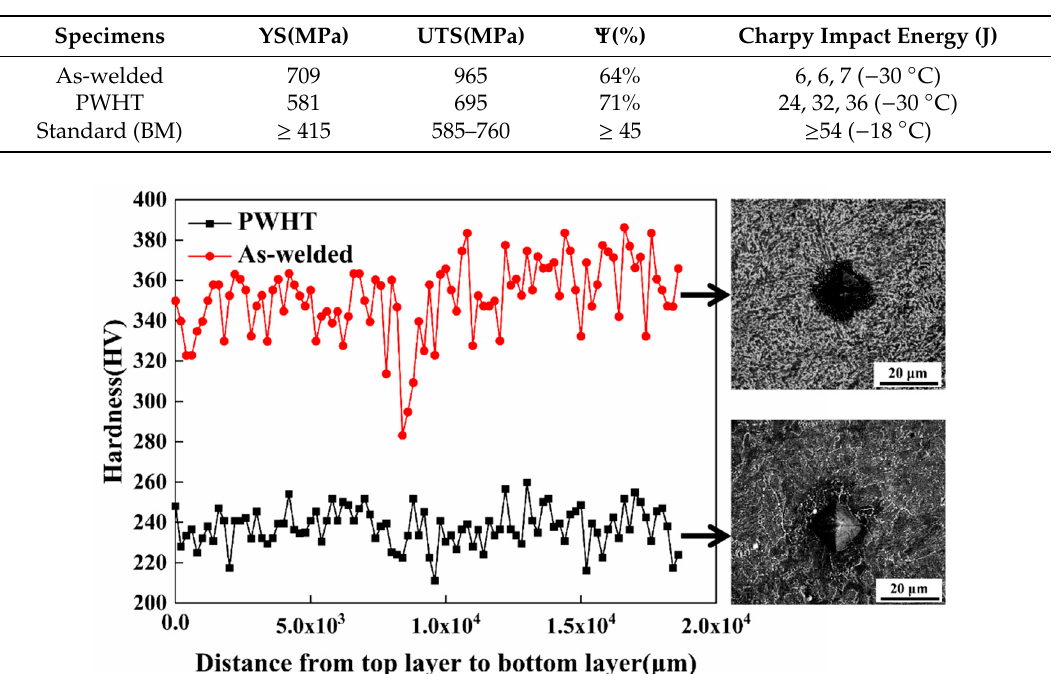
Figure 5. Hardness of the weld metal for as-welded and PWHT specimens. Table 2. Mechanical properties of the weld zone